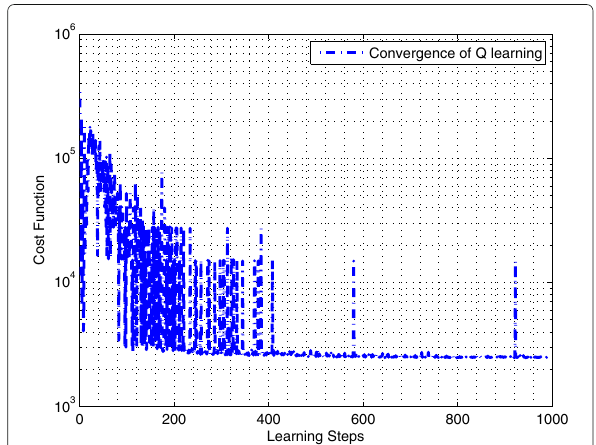
handoff decisions based on greedy policies and cognitive control policies are illustrated. Obviously, reedy policies bring frequent Ping-Pong handoffs while few Ping-Pong handoffs happen under cognitive control polices. Details of handoff decisions are shown in the enlarged part in Fig. 14. Performance of handoffs is demonstrated in Fig. 15, where handoff latency under greedy policies is much higher than that under cognitive control policies.